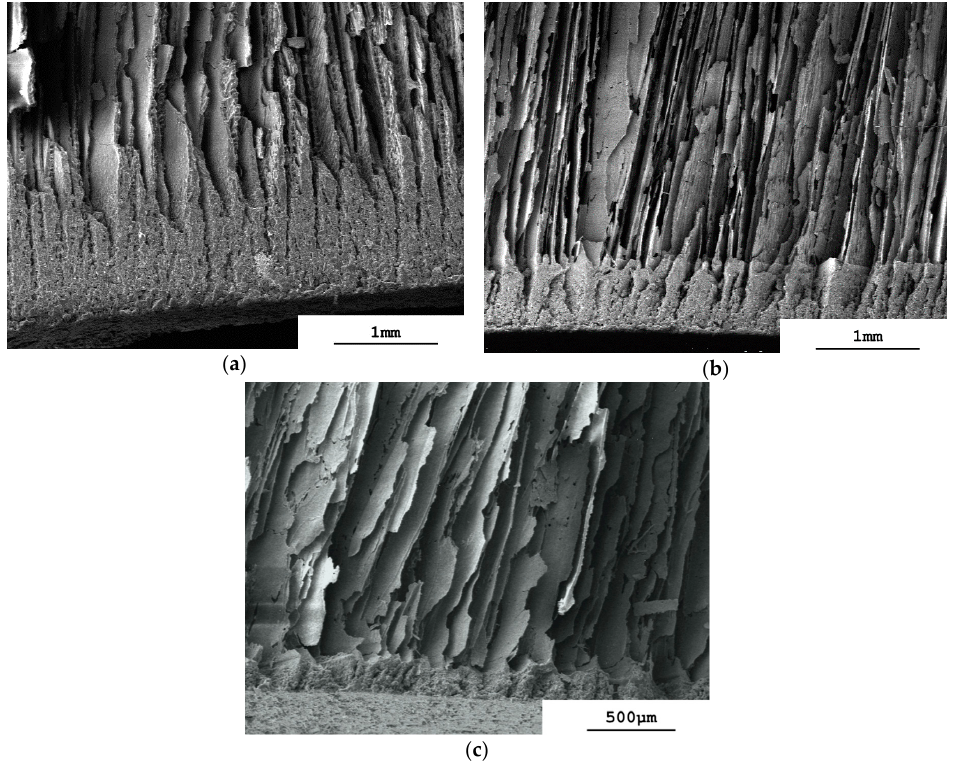
Figure 4. Scanning electron micrographs of longitudinal sectioned sintered monoliths to show detail of base region showing dense appearance. ( a ) φ v = 0.128; ( b ) φ v = 0.064; ( c ) φ v = 0.032. X-ray micro-computed tomography (µCT) gives sinograms that visualize directly the three-dimensional pore network within the sintered monoliths. The vertical arrangement of the lamellae and pores is revealed by taking two-dimensional cross-sections through each monolith at different vertical heights, h, of approximately 0.9, 0.5 and 0.1, each at ±50 slices (approximately 2200 slices each of 8.9 µm thickness were resolved over the total monolith height, h = 1, of approximately two centimeters). The positions of h within the φ v = 0.128 membrane are marked in Figure 1a and the corresponding cross section images given in Figure 5a–c. At h = 0.9, i.e., at 90% of total height, Figure 5a shows the pattern of dark pores that are separated by the lighter-shaded lamellae of the sintered alumina. It is immediately obvious that the pores and lamellae are not oriented uniformly over the cross-section. In the left-hand hemisphere the pores and lamellae in the periphery are oriented radially. In the right-hand hemisphere many pores and lamellae run across the periphery as parallel chords. On moving away from the periphery towards the center the lamellae and pores now exist as individual domains, where each domain comprises a group of parallel lamellae/pores. The numerous domains are randomly oriented to one another. The existence of such domains or “colonies” has been observed before in regularly freeze-casted ceramics at “high” freezing rates (i.e., 20–30 µm/s [28]) and have the same intra-domain alignment of pores [28,29] but with no long-range order [30]. Recall that the estimated freezing rate with vacuum-induced surface freezing is 30 µm/s [18]. This non-uniform orientation over the cross-section explains the appearance of the lamellae visualized by SEM in Figure 1a. When viewed longitudinally, the monolith of Figure 5a will show lamellae sectioned at different angles because of the different orientations of the lamellae/pores in the domains. A similar pattern of lamellae/pore structure is seen deeper in the monolith at h = 0.5 (Figure 5b) with radial and chord orientation in the periphery and random domains in the center. It is, however, evident that both the lamellae and pores are larger at h = 0.5 than at h = 0.9. Despite this,